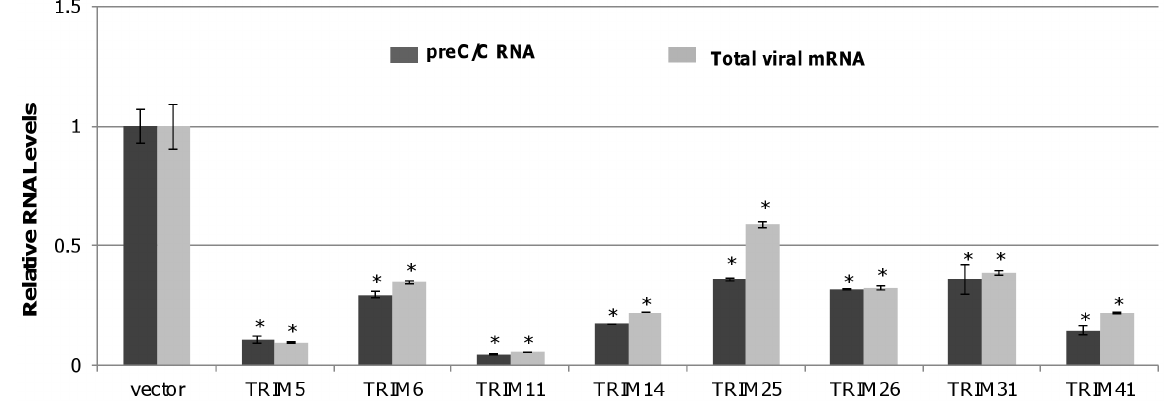
Figure 2. Eight TRIM proteins can efficiently reduce the amount of HBV mRNA in HepG2 cells. HepG2 cells in 12 well plates were co- transfected with 0.4 m g of pHBV1.3 and 0.4 m g of vector plasmid or plasmid expressing one of eight TRIM proteins. Two days post transfection, cells were harvested and total cellular RNAs were extracted. The levels of preC/C RNA and total viral mRNA were quantified by a quantitative RT-PCR assay. The mean and standard deviations (n=3) were presented. * and ** indicate P , 0.05 and 0.01, respectively.